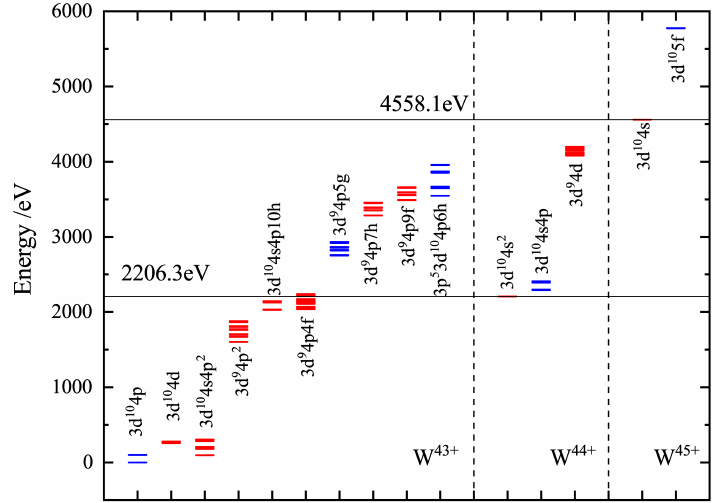
Figure 6. Energy levels of the major configurations of W 43 + , W 44 + , and W 45 + ions that we calculated relevant to the present study. Even configurations are shown in red, odd configurations are shown in blue. Horizontal lines: the thresholds for single and double ionization of W 43 +